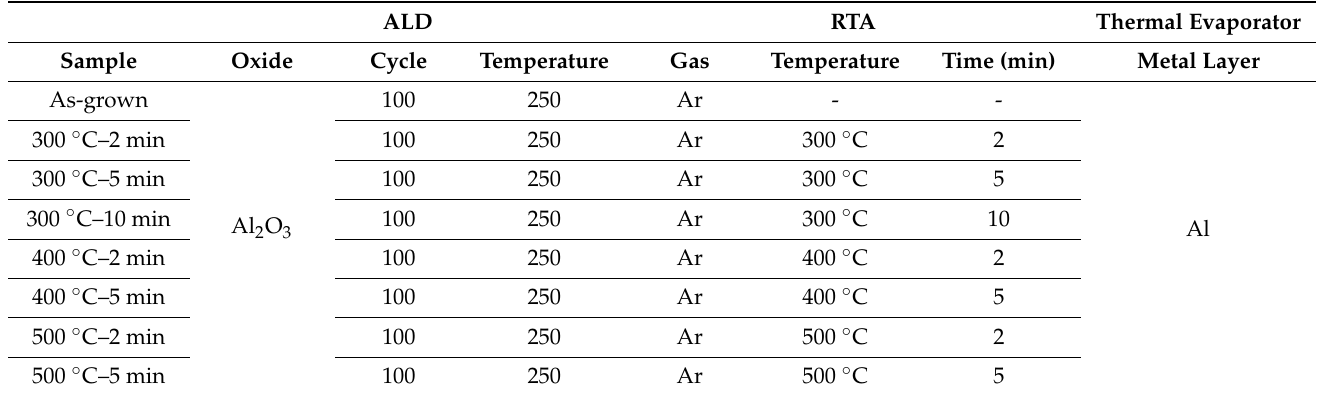
Table 1. Conditions of parameters used for MOSCAP